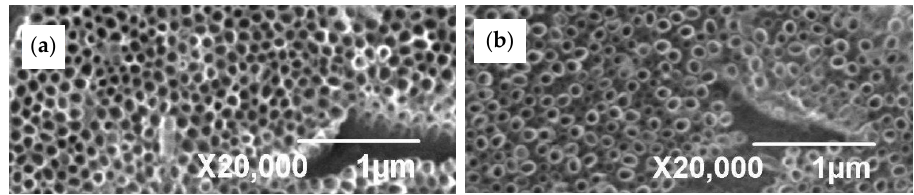
Figure 4. Details of SEM SEI images of the anodized surfaces ( a ) ground and ( b ) polished. Table 1. Dimensions of nanotubes (NT) before and after heat treatment of the Ti6Al4V substrates. NT Dimensions Sample